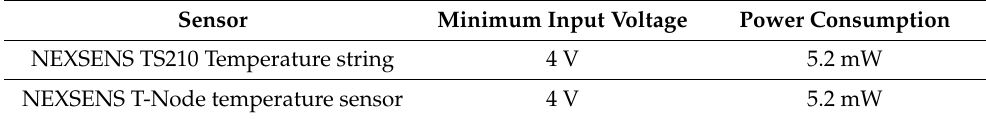
Table A1. Water temperature